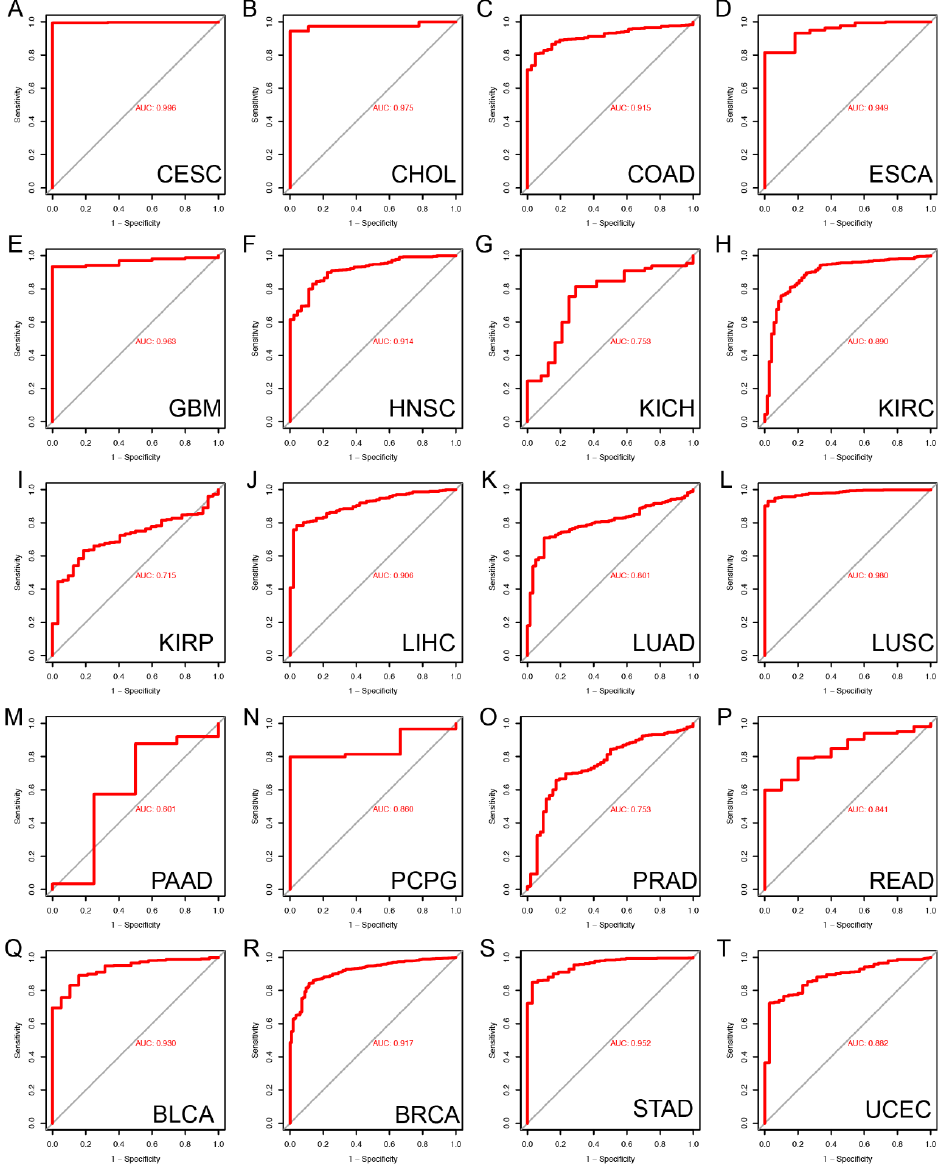
Figure 3. Accuracy of FAM72A in discriminating tumor from normal tissue in pan-cancer. ( A – T ). The area under the curve (AUC) of the receiver operating characteristic (ROC) for indicated tumors. 2.4. Correlation between FAM72A and Tumor Microenvironment in Different Tumors Intratumoral stromal and immune cells constitute the majority of tumor-associated normal cells. Not only immune cells but also stromal cells regulate tumor growth and progression. The Estimation of Stromal and Immune cells in Malignant Tumor tissues us- ing Expression data (ESTIMATE) algorithm was used to evaluate infiltrating immune and stromal cells by calculating immune scores and stromal scores. FAM72A expression was found to positively correlate with the immune score in KIRC, KIRP, LGG, KIRC, thyroid carcinoma (THCA), UVM, and PCPG, but negatively correlated with the immune score in CESC, STAD, LUSC, UCEC, HNSC, READ, COAD, and ESCA (Figure 4A). Regarding stromal score, a positive correlation with FAM72A expression was seen in THCA, PCPG,